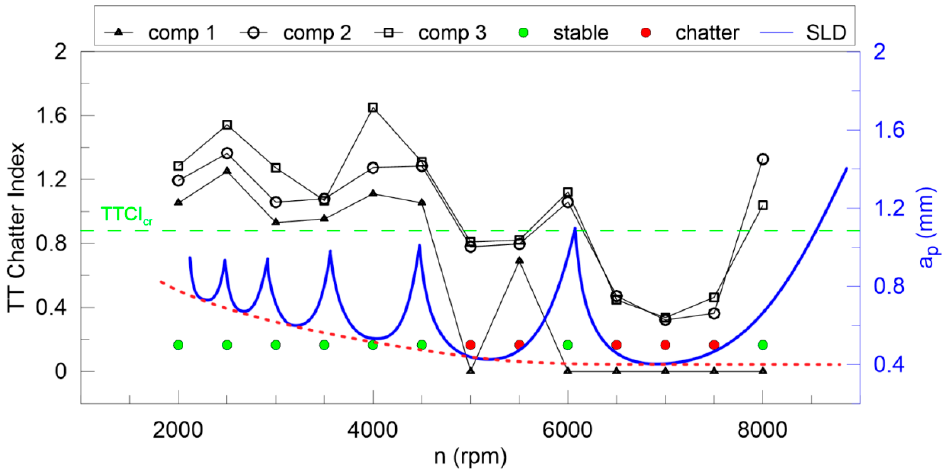
Figure 17. The TT chatter index (left axis) and the hypothetical stability lobe diagram (right axis) versus cutting velocity.